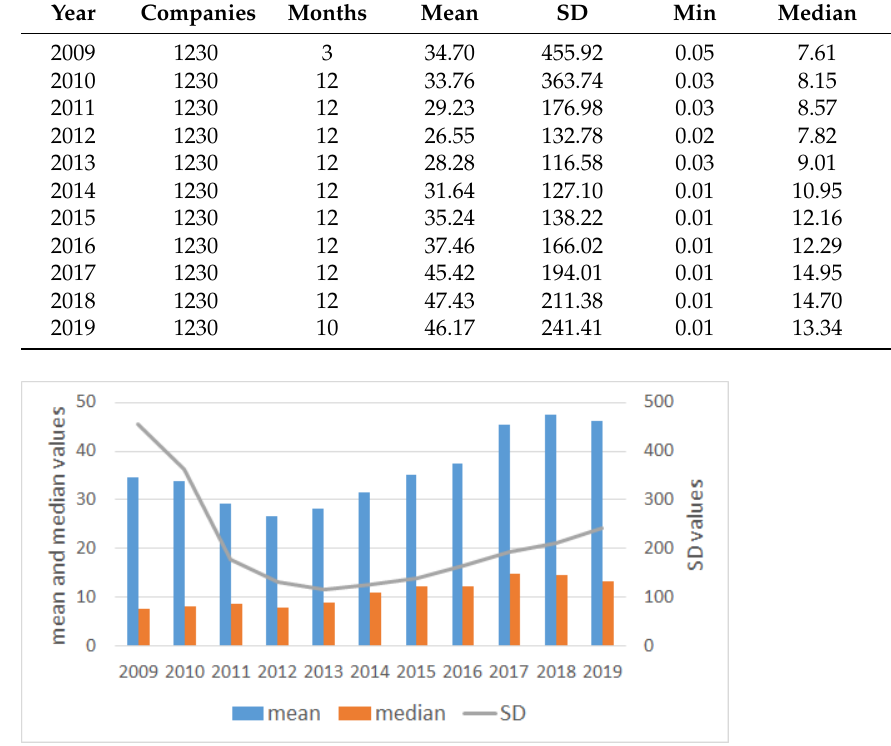
Figure 1. Summary statistics of the data by